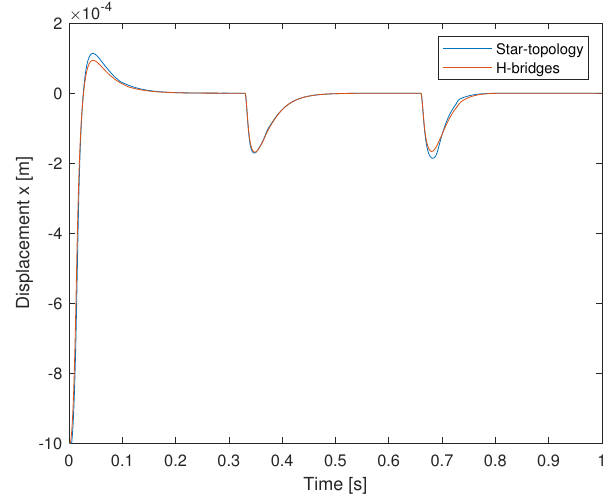
Figure 12. Displacement comparison on x-axis.